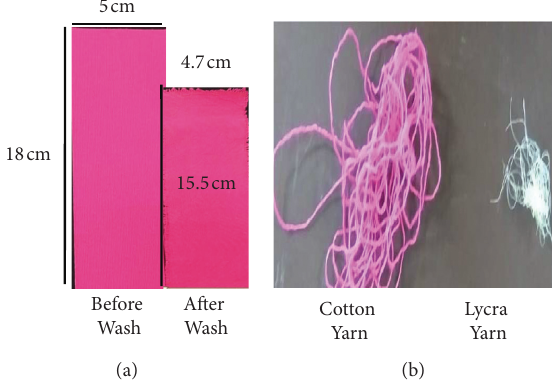
Figure 6: (a) Tape after wash and before wash. (b) Cotton and lycra yarn.